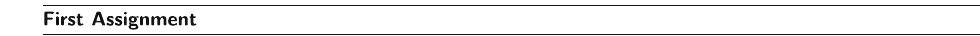
Figure 9: Background information given to the participant after the training phase has completed. This is then followed by the actual assignment shown in Figure 10.